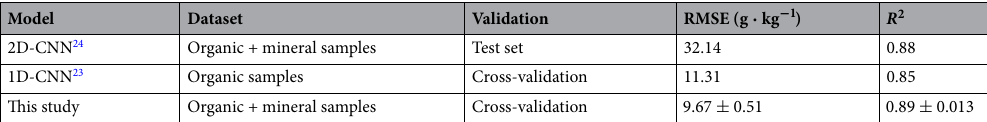
Table 3. Comparison of CNNs. The 2D-CNN and our optimised 1D-CNN were developed using the organic and mineral samples in the LUCAS dataset. The 1D-CNN 23 was developed using only the organic